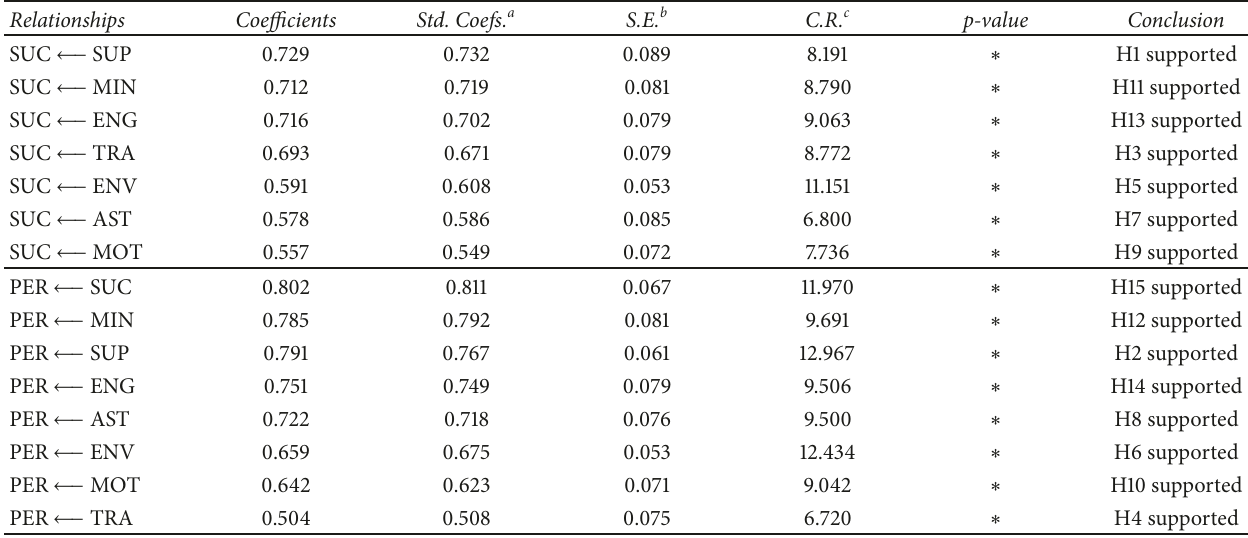
Table 7: Coefficients from the SEM model.